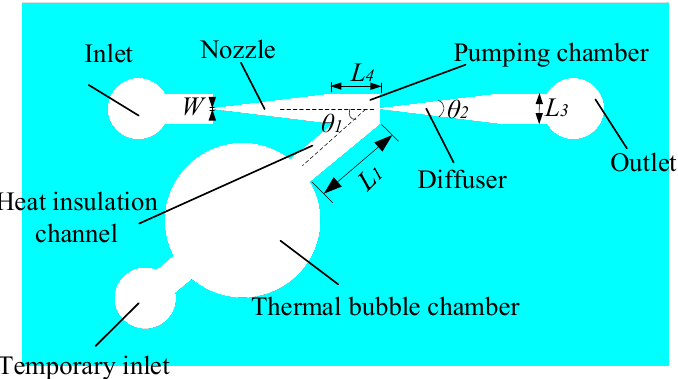
Figure 2. Schematic drawing of the PDMS chip of the heat source insulation micropump.